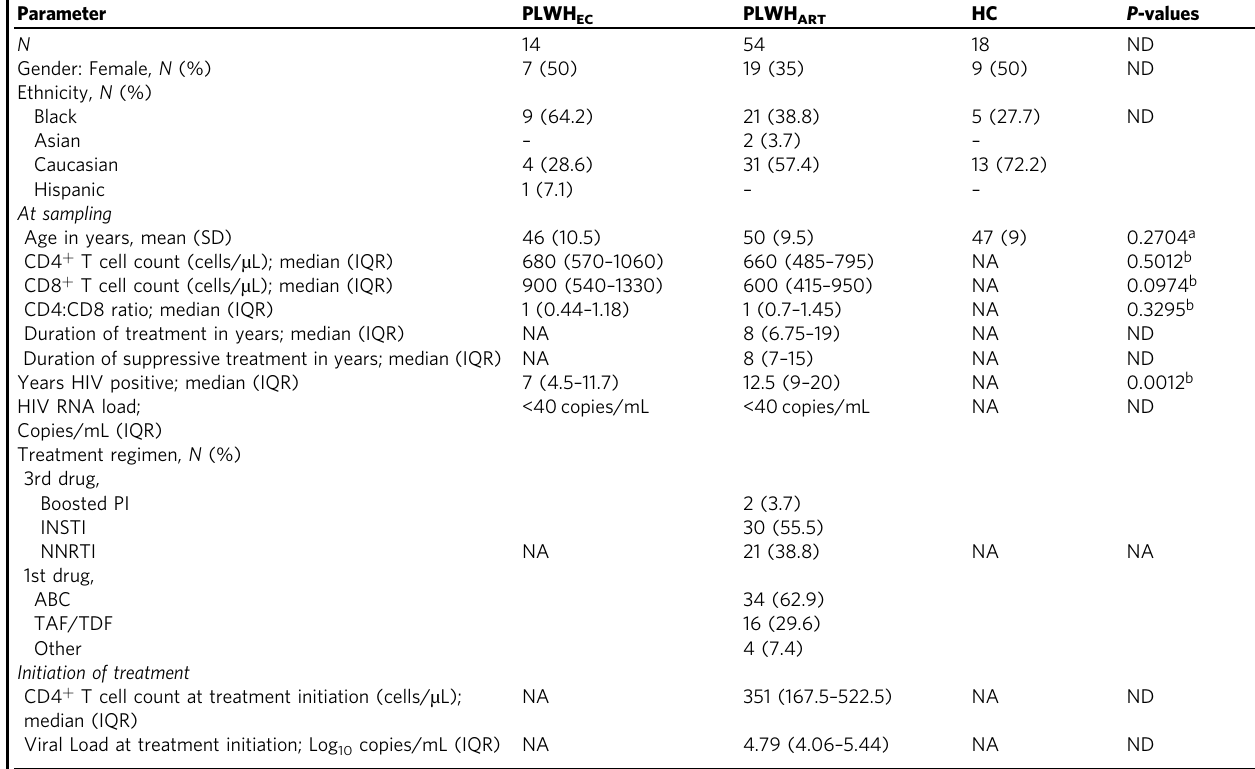
Table 1 Patient